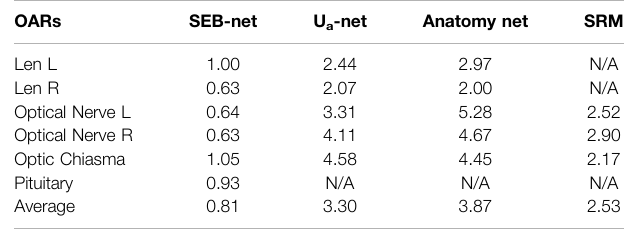
TABLE 5 | Average 95% HD comparison for small organs on the test (unit: